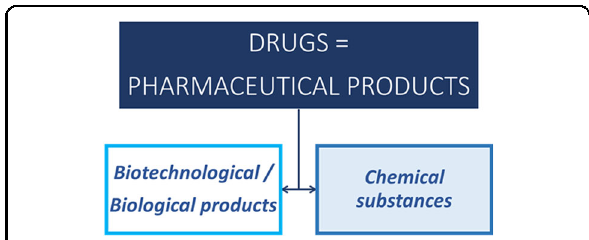
Fig. 2 Different regulatory frameworks in ICH 7 guidelines based on the nature of the medicinal product.